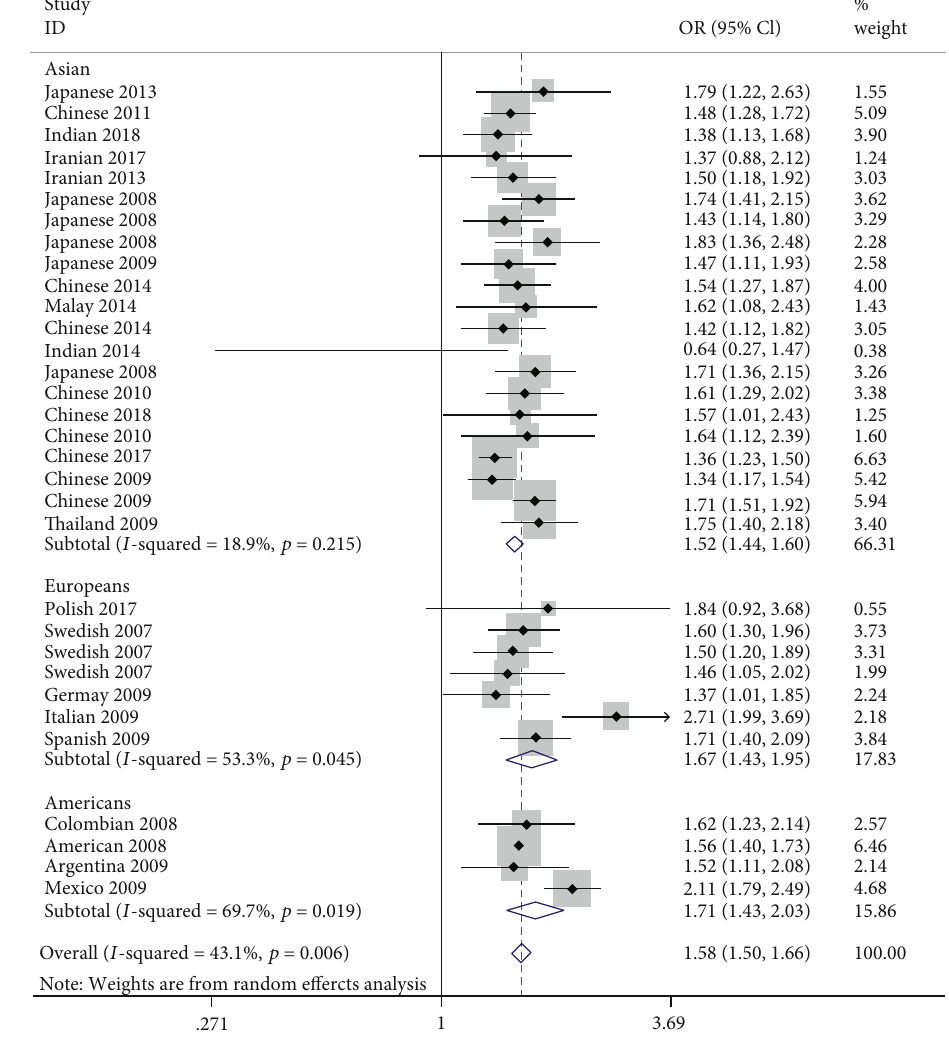
Figure 3: Forest plot for meta-analysis of STAT4 rs7574865 polymorphism and SLE in each ethnic